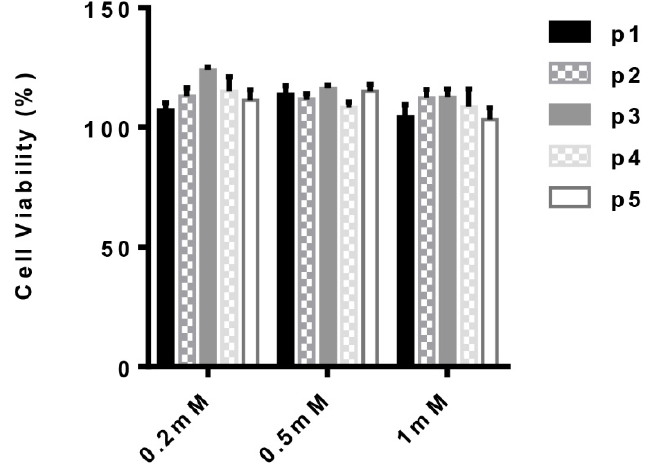
Figure 2. Cell viability of human monocyte (THP-1) cells treated with DIKTNKPVIF (p1) and its digestive fragments DIKTNKPVI (p2), TNKPVIF (p3), DIK (p4) and TNKPVI (p5) compared to untreated cells. Bars represent mean values ± S.D.